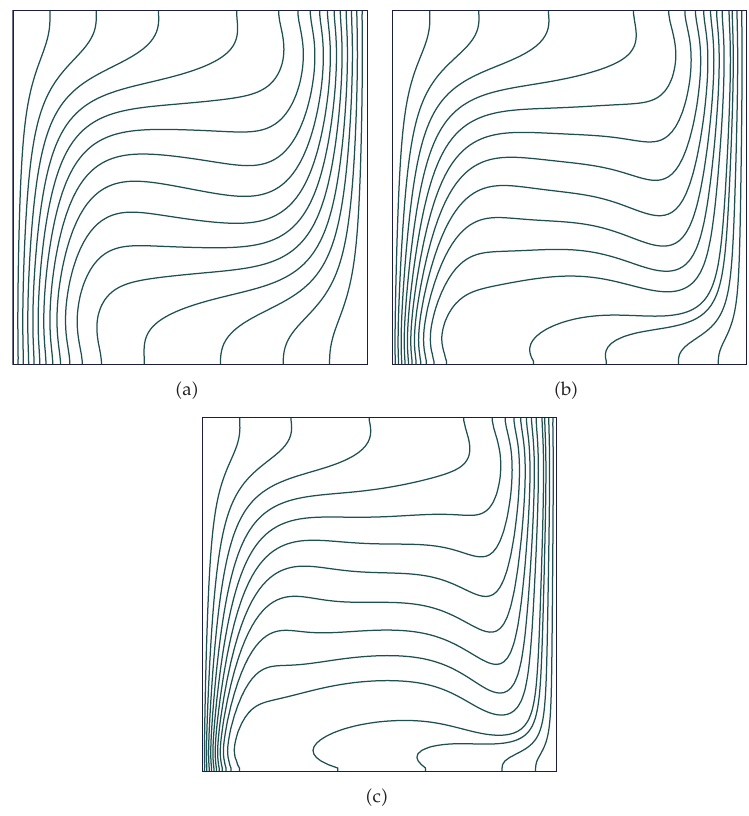
Figure 4: Isotherms for the thermomagnetic flow in a square cavity for Δ T (cid:8) 60K, Ra (cid:8) 2 × 10 4 : (cid:3) a (cid:4) m (cid:8) 0 . 0, (cid:3) b (cid:4) m (cid:8) 0 . 05, and (cid:3) c (cid:4) m (cid:8) 0 .